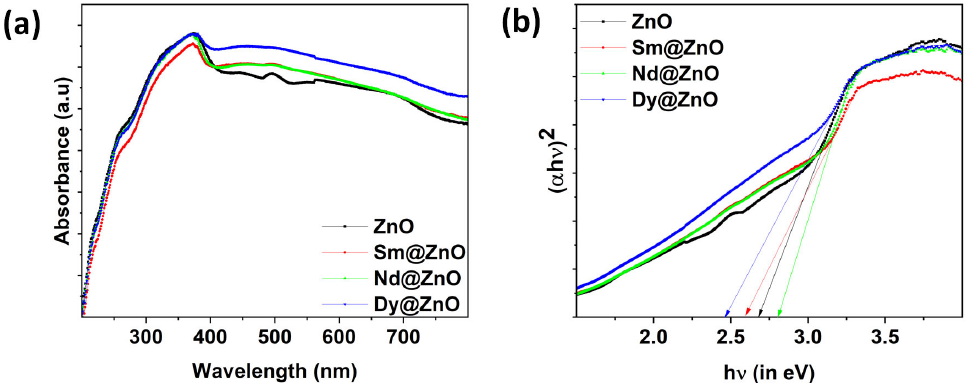
Figure 6. ( a ) Absorbance spectra for all synthesized samples, ( b ) Tauc’s plot obtained using ab- sorbance data.